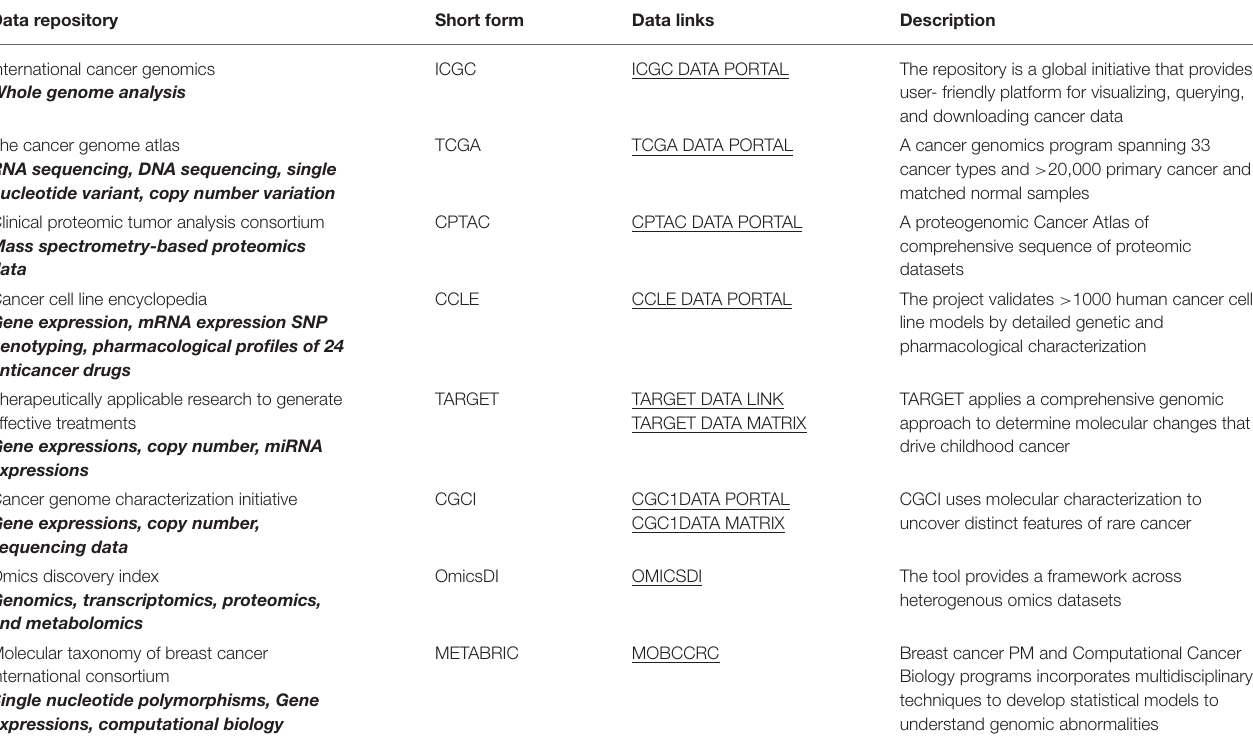
TABLE 1 | Description of multi-omics data repositories related to